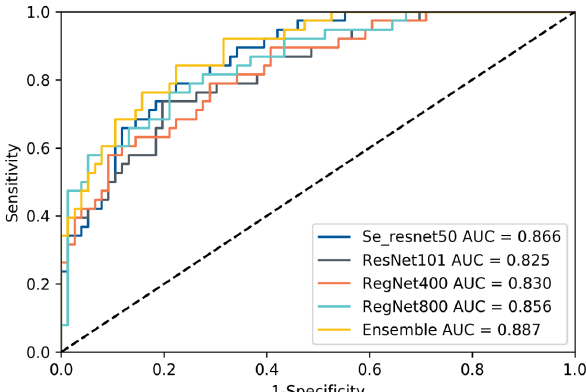
Figure 3. Receiver operating characteristic (ROC) curve of the four different models and the ensemble